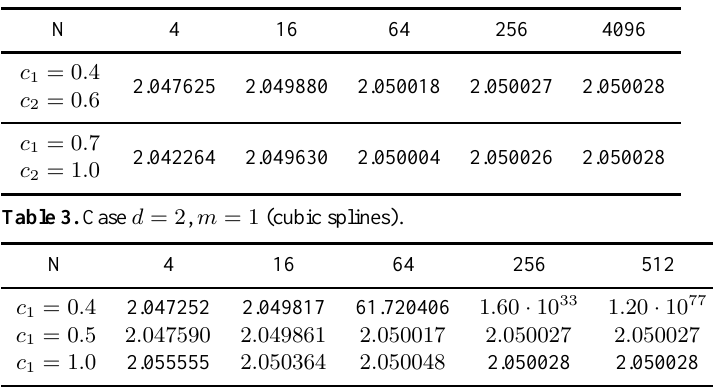
Table 2. Case d = 1 , m = 2 (Hermite cubic splines).